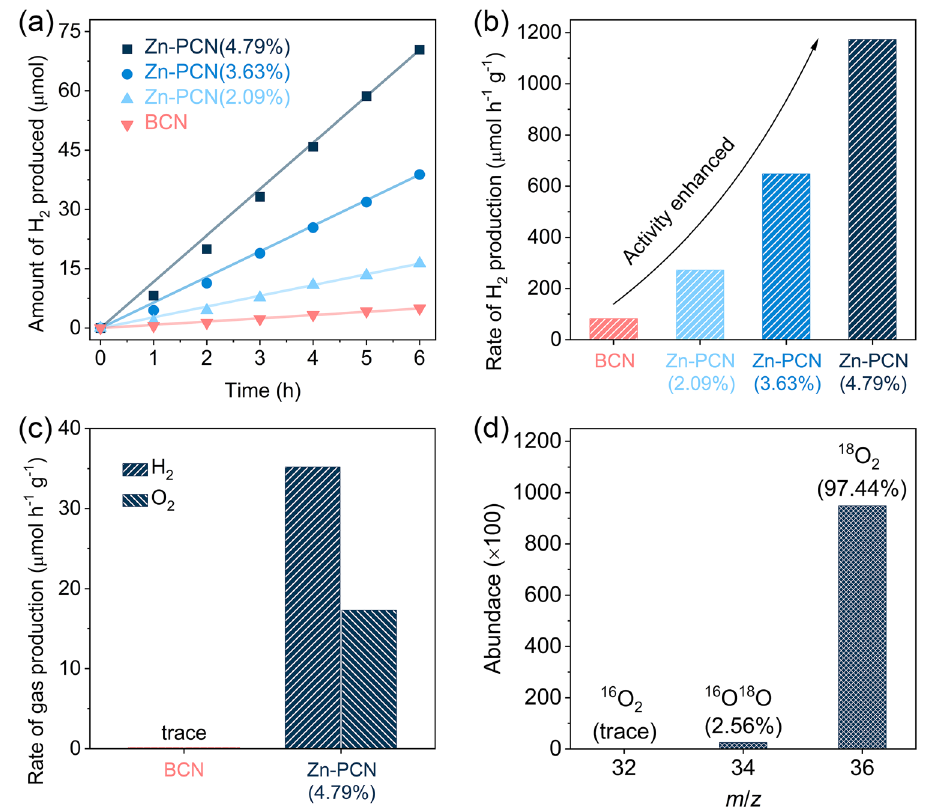
Fig. 5 a Amounts of H 2 produced and b H 2 production rates of BCN and Zn‑PCN from TEOA aqueous solutions under visible‑light irradiation ( λ > 420 nm). c Photocatalytic overall water splitting performance over BCN and Zn‑PCN (4.79%) under visible‑light irradiation ( λ > 420 nm). d The mass spectrum data of O 2 evolved from photocatalytic H 218 O (99%) splitting over Zn‑PCN